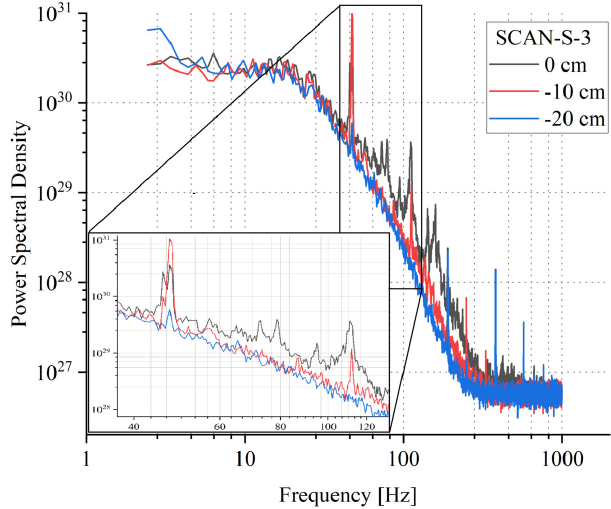
Figure 12. Power spectral densities of the time series n(t) recorded at various positions y during SCAN-S-3. The insert shows the peaks in the spectrum described in the